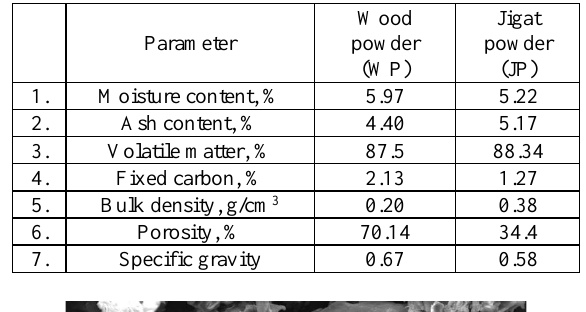
Table 5. Physical properties of WP and JP